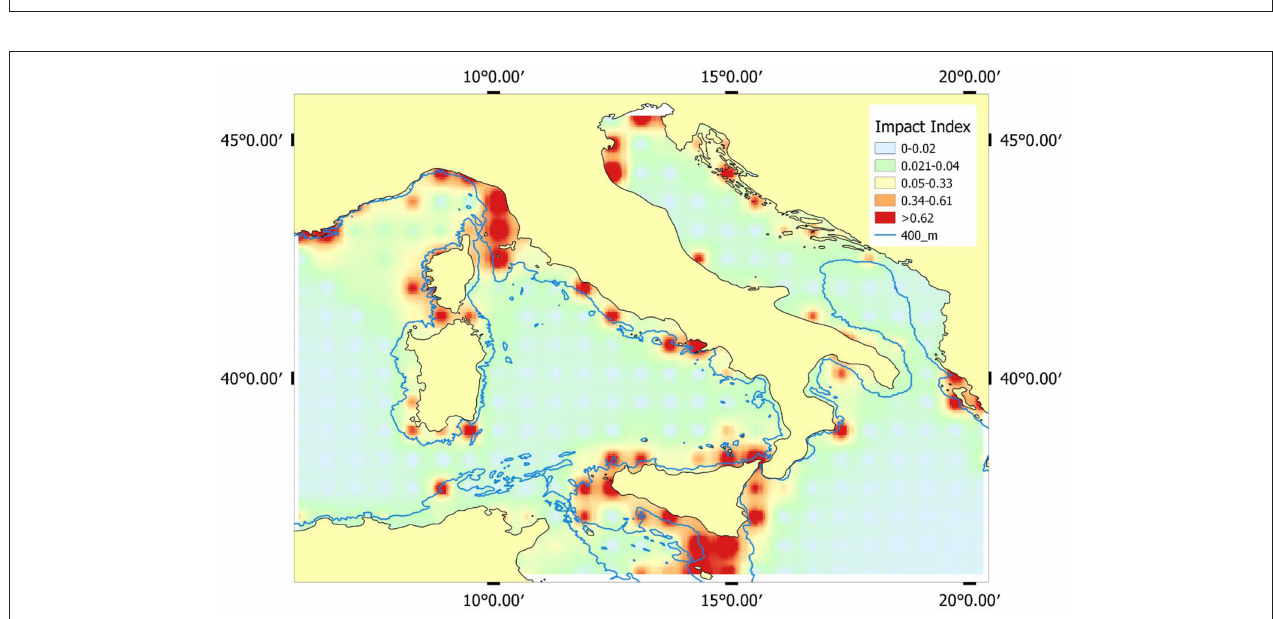
FIGURE 12 | Map of the Cumulative Pressure Index (CPI).